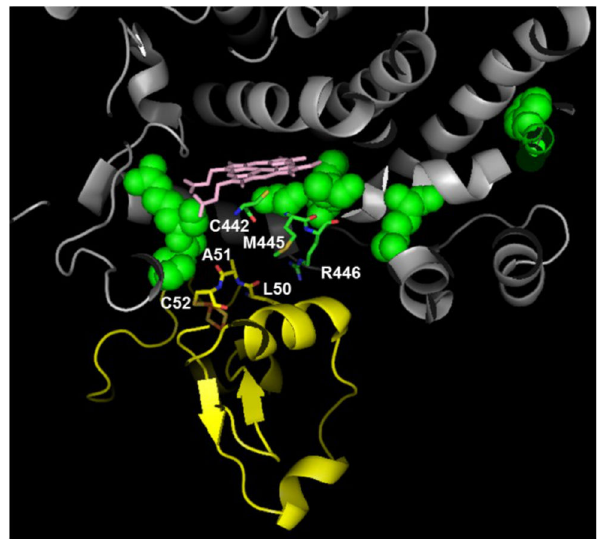
Figure 3. Molecular components of the catalytic network of the CYP3A4-adrenodoxin (Adx) complex. Adx is a small iron-sulfur protein that transfers electrons from NADPH to terminal CYP as part of the overall metabolic processing of substrates. We used the structural complex of this enzyme with eukaryotic CYP (CYP11A1) to model a CYP3A4-Adx complex. Selected molecular components of the modeled electron transfer pathway from the CYP3A4 heme iron to the Adx are shown, where the CYP3A4 unit is shown in gray, the Adx unit is shown in yellow, and the residues in the CYP3A4 catalytic networks are shown in green. The heme group is shown in pink, and the CYP3A4 C411 residue is shown in red. All residues involved in the predicted electron-transfer pathway are shown as sticks.